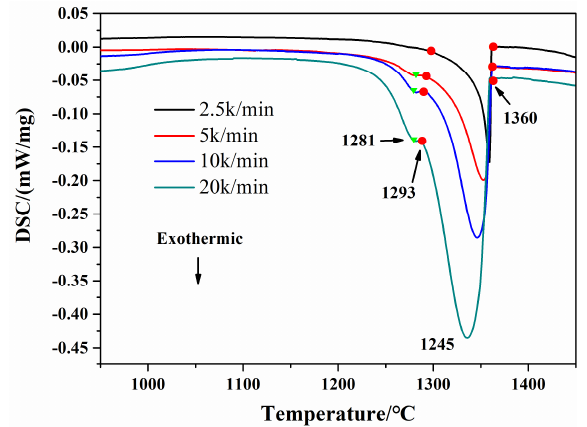
Figure 4. DSC curves of the alloy cooled from super-solidus temperature, the cooling rates are 2.5 K/min, 5 K/min, 10 K/min and 20 K/min, respectively.